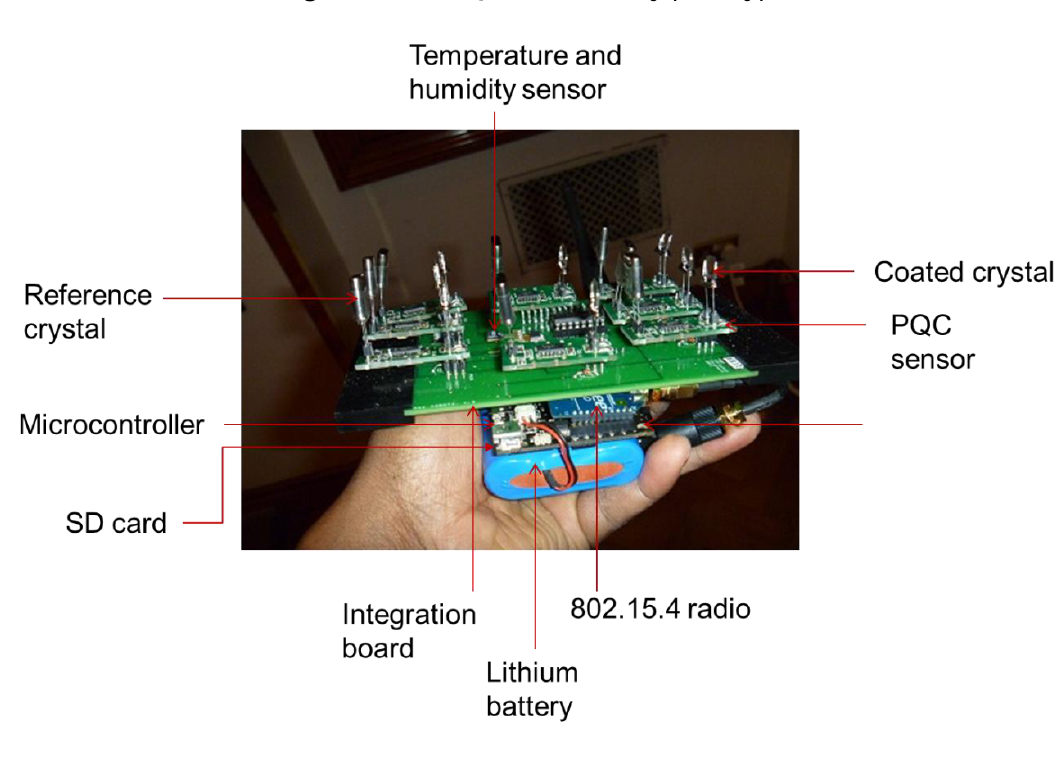
Figure 2. The PQC sensor array